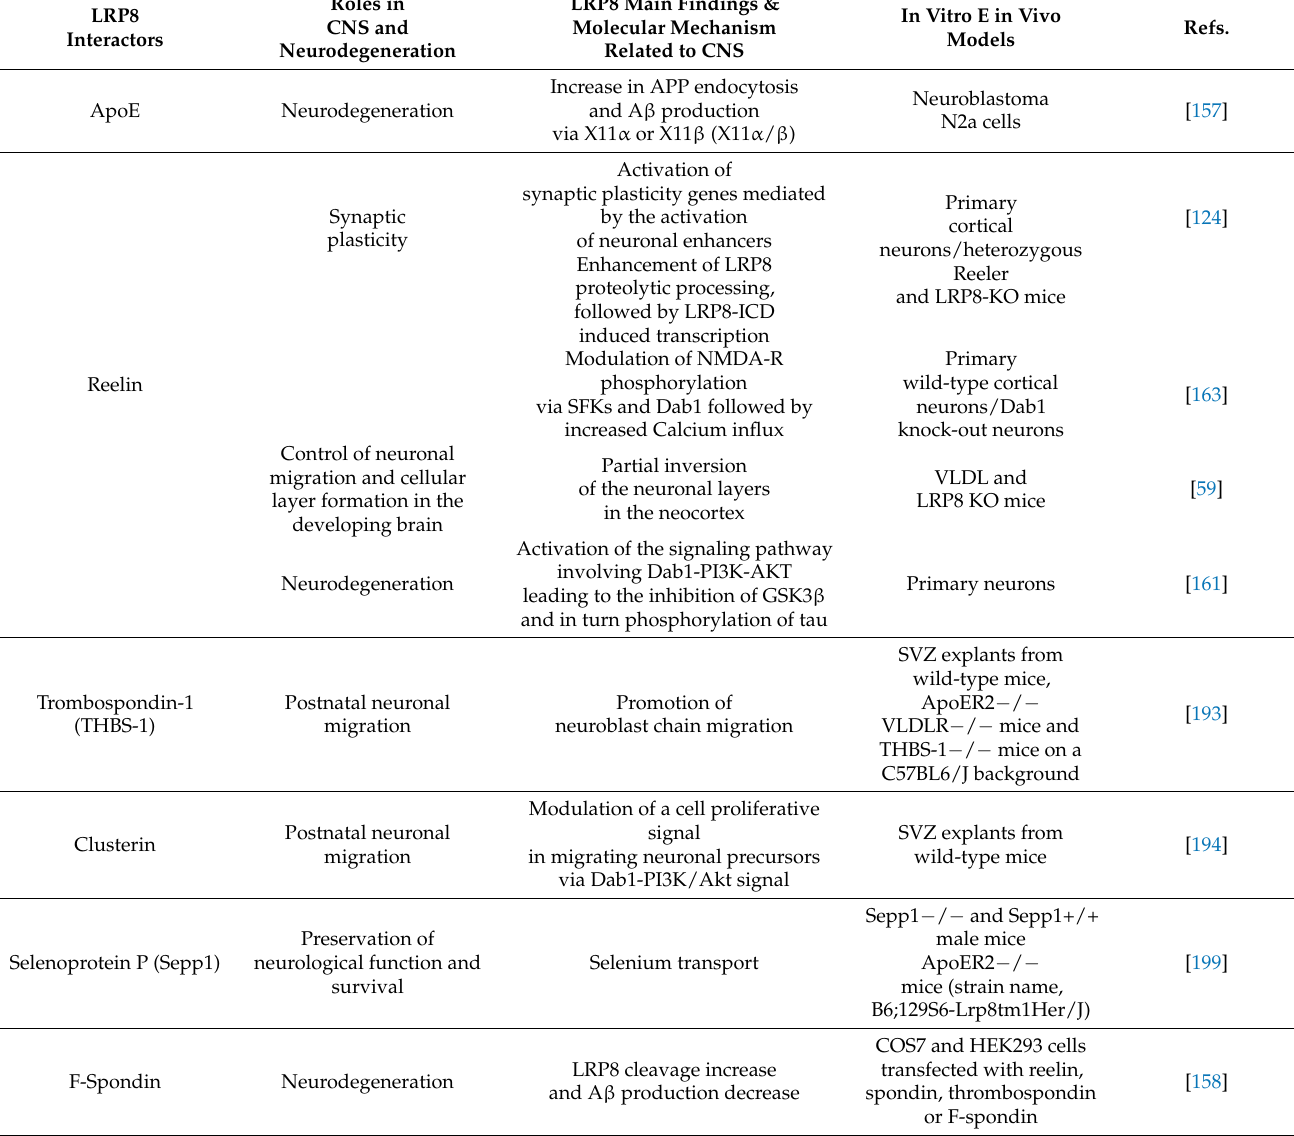
Table 3. LRP8 in CNS- and neurodegeneration-related molecular pathways. The table summarizes main findings in CNS and neurodegeneration correlating LRP8 and its ligand binding to correspond- ing roles, molecular mechanisms and in vitro and in vivo models used in the experimental studies taken into consideration (see